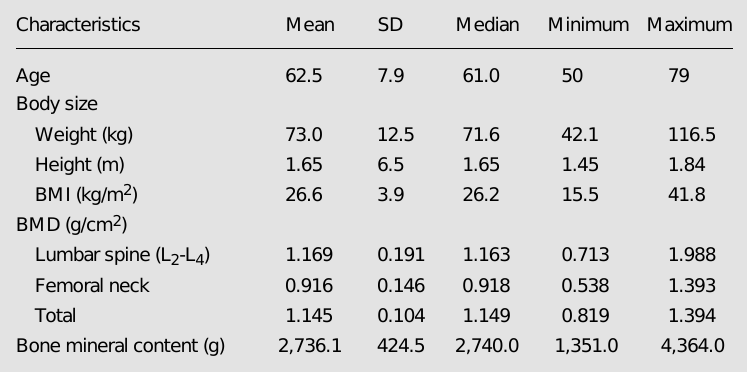
Table 1 - Body size and bone mineral density (BMD) of 288 healthy men, aged 50 years and more.